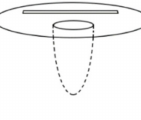
Figure 1. Plastic custom container to fit root sample during treatment and retreatment